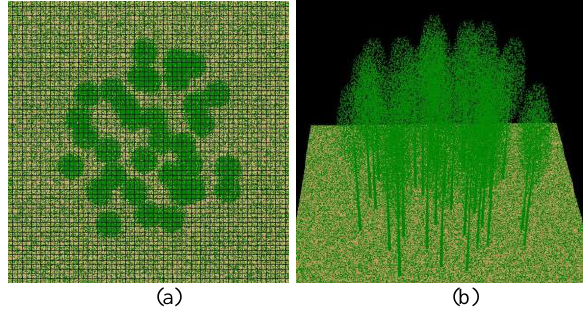
Figure 1. 3-D tree created by the Blender